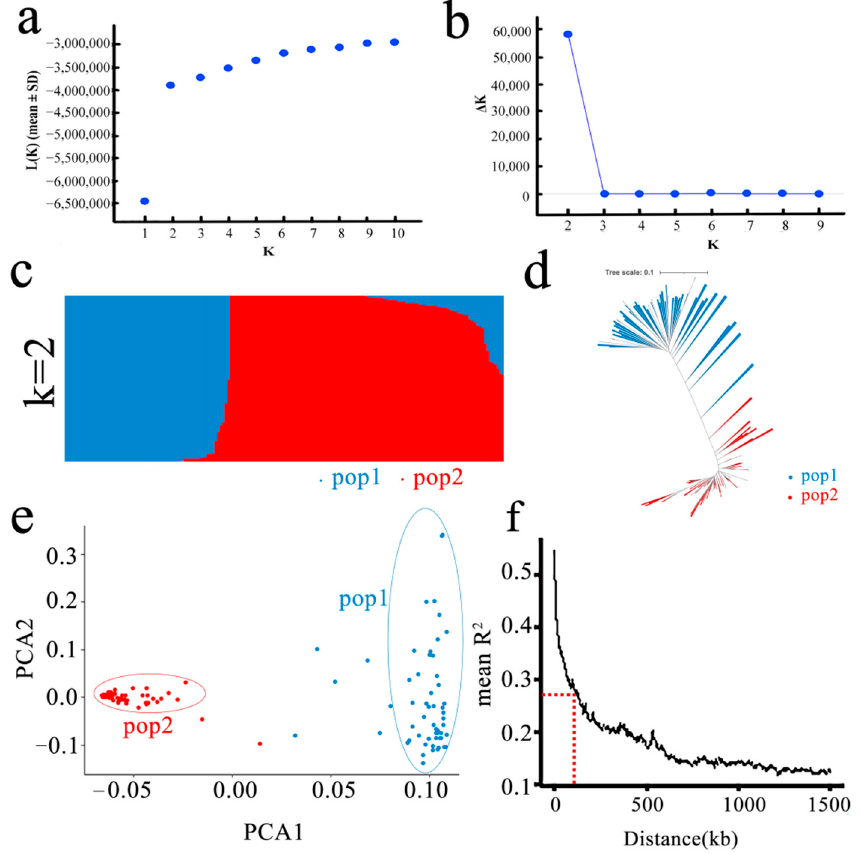
Figure 4. Genetic structure analysis of natural population constructed from 173 rice accessions: ( a ) Change of logarithmic likelihood with subgroup number; ( b ) Δ K value variation with subgroup number; ( c ) Natural population structure (K = 2). Blue and red colors represent pop1 and pop2 in Figure 4b, respectively; ( d ) Neighbor-joining tree of natural rice population. Blue and red colors represent pop1 and pop2 in Figure 4b, respectively; ( e ) Principal component analysis of natural rice populations. Blue and red colors represent pop1 and pop2 in Figure 4b, respectively and ( f ) LD decay analysis of the whole genome in natural rice populations.